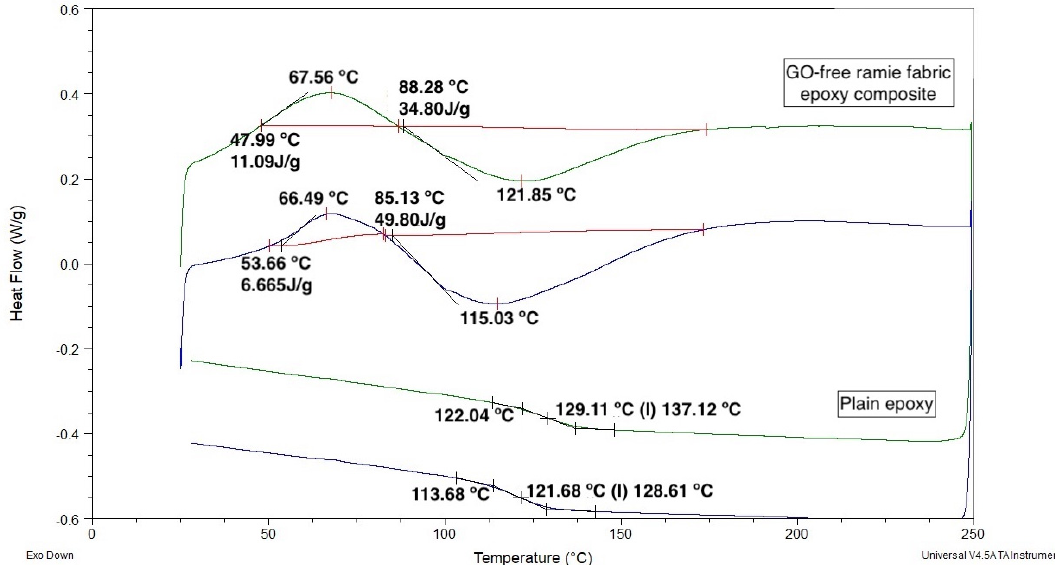
Figure 8. DSC curves for one heating and cooling cycle of plain epoxy (lower side) and GO-free epoxy matrix composite reinforced with 30 vol% ramie fabric (upper side).